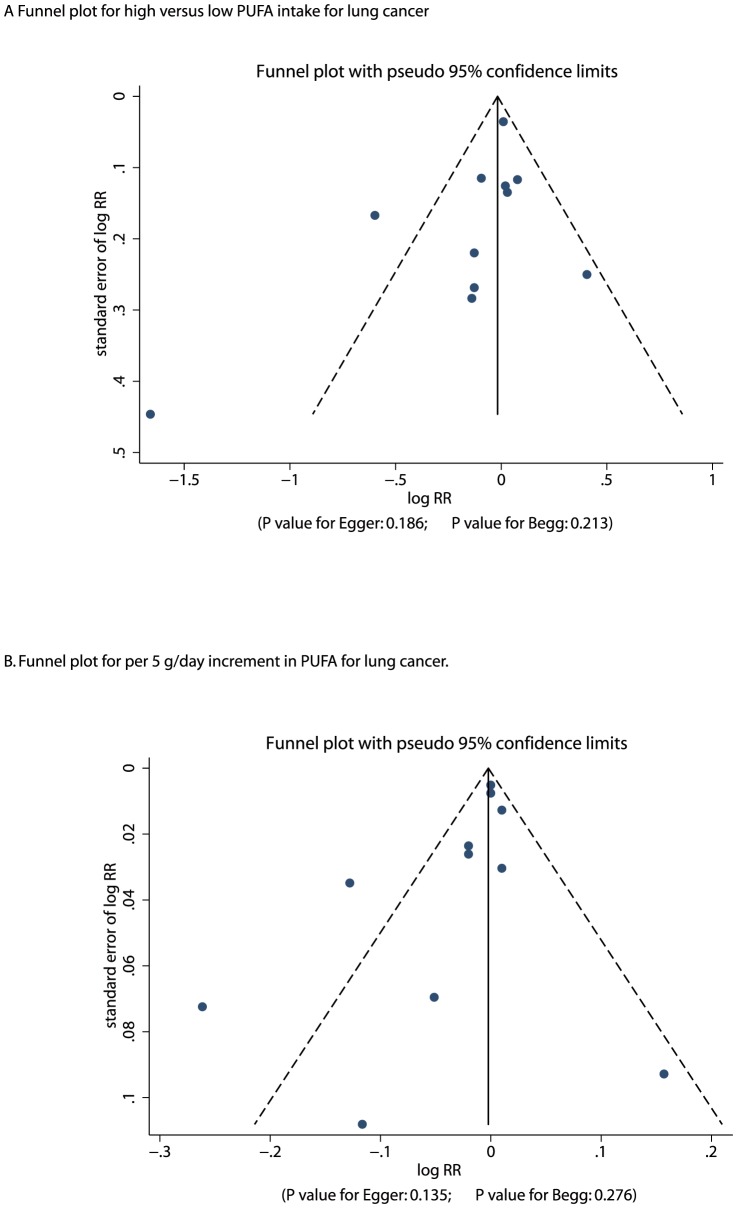
Funnel plot for high versus low PUFA intake for lung cancer (A); Funnel plot for per 5 g/day increment in PUFA intake for lung cancer (B).